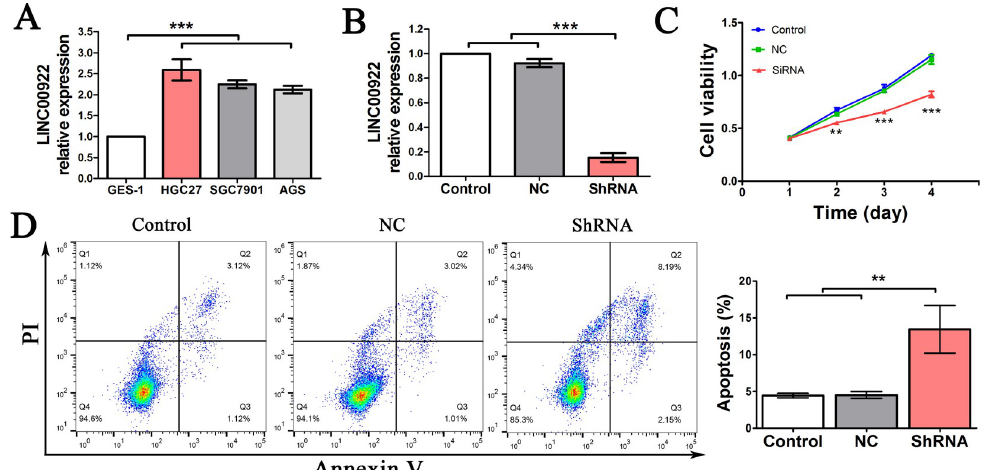
Fig 4. Expression of LINC00922 and GC cell proliferation and apoptosis. (A) Expression of LINC00922 in different GC cell lines, as assessed by RT-PCR. (B) LINC00922 expression in HGC27 cells was examined by RT-PCR. LINC00922 expression was decreased in the ShRNA group compared with the control group (P < 0.05). (C) Cell growth curve of control cells and those transfected with shRNAs and NC. (D) Cell apoptosis was determined by flow cytometry. The apoptosis rate was increased in the ShRNA group compared with the control group (P < 0.05). �� P < 0.01, and ��� P <